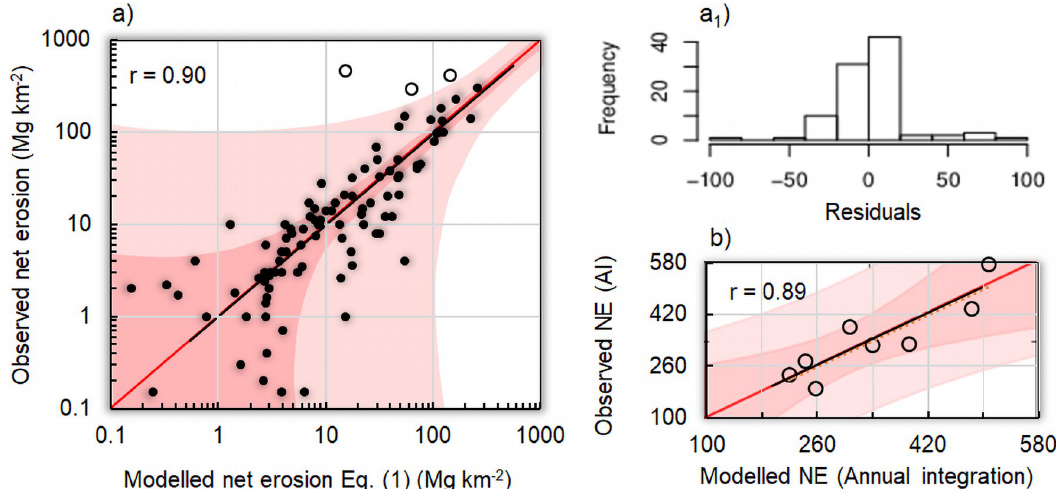
Fig 3. Model evaluation. a) scatterplot (log-scales) of regression model (black line and 1:1 red line) versus experimental net erosion estimated at the outlet of Magra River Basin over the years 1961, and 1963–1969 with the inner bounds showing 90% confidence limits (power pink coloured area), and the outer bounds showing 95% prediction limits for new observations (light pink), out of which three outlier data are marked in empty circle and not considered for model calibration. a 1 ) residuals between actual and modelled net erosion. b): Scatterplot between the annual actual and modelled net erosion values (Mg km -2 yr -1 ), with 1:1 (red line), regression line (black line), and related confidence limits (power and light pink bands as in a).